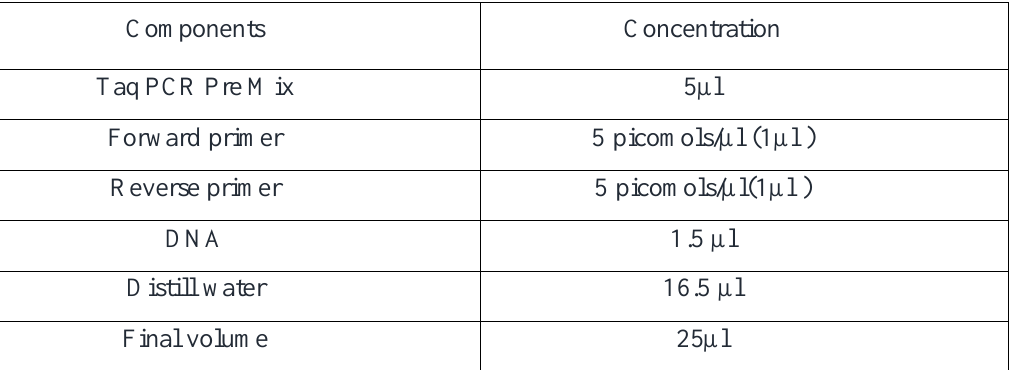
Table 2: The Maxime PCR kit (i-Taq) Components with their